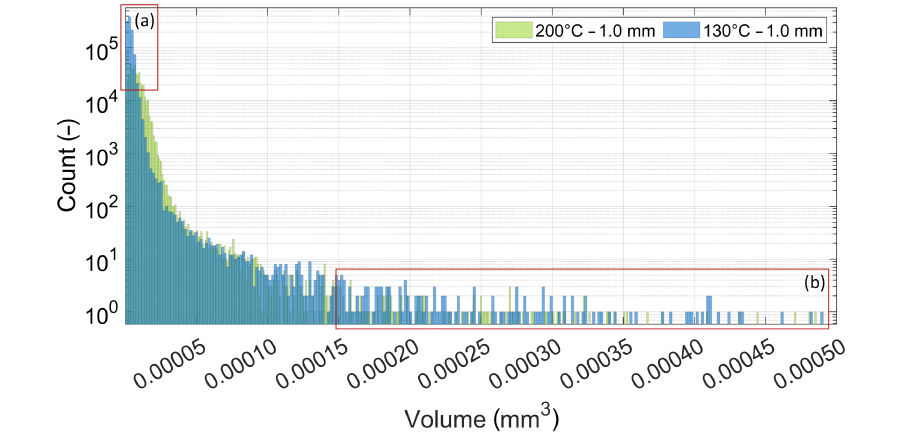
Figure 5. Quantitative analysis of the pore count for different pore volumes for the single-strand specimen at a substrate temperature of 200 °C and 130 °C and a layer height of 1.0 mm.